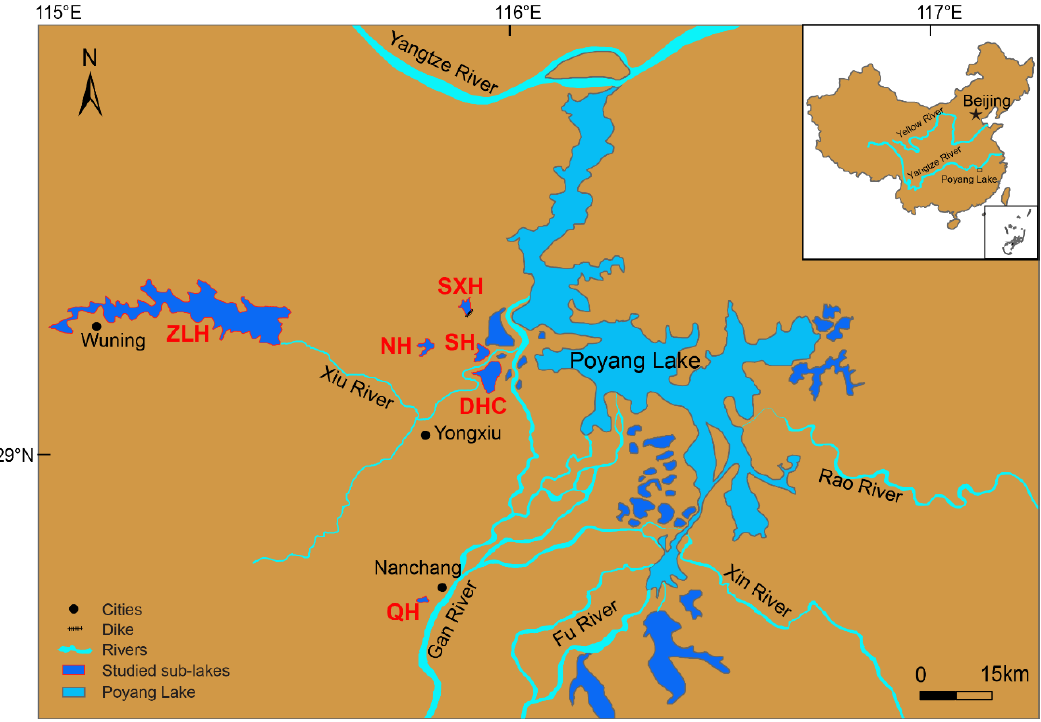
Figure 1. Map of sampling sites. Six sampling sub-lakes (DHC, SH, NH, SXH, ZLH and QH) of Poyang Lake were marked red.